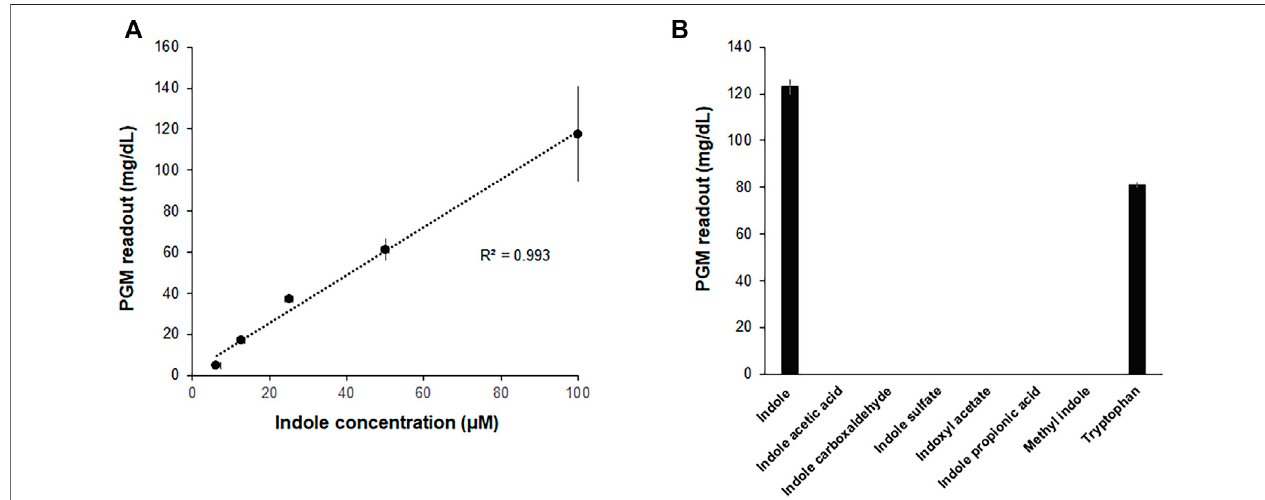
FIGURE5| MeasurementofindolebyaPGM.TheassaymixtureforIndole-CCFPSwasprogrammedwiththetemplateDNAencodingbacterialinvertase.15 μ Lof the assay mixture was transferred to an Eppendorf tube containing 15 μ L of 200 mM sucrose prepared in PBS and further incubated for 10 min at 37 ° C. After heat- inactivation of invertase, the glucose titer was measured in 5 μ L of the supernatant from the brie fl y centrifuged reaction mixture using a PGM (Accu-Check Inform II, Roche Diagnostics). (A) The PGM readouts were measured for varying concentrations of indole. (B) The assay mixture for Indole-CCFPS was supplied with the same concentrations (100 μ M) of indole, and measured for the glucose concentration using a PGM. Measurements were performed in triplicate, and the error bars represent the standard deviations of three independent experiments.